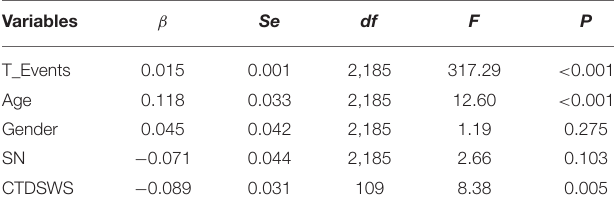
TABLE 3 | Cross-level analysis for the multilevel